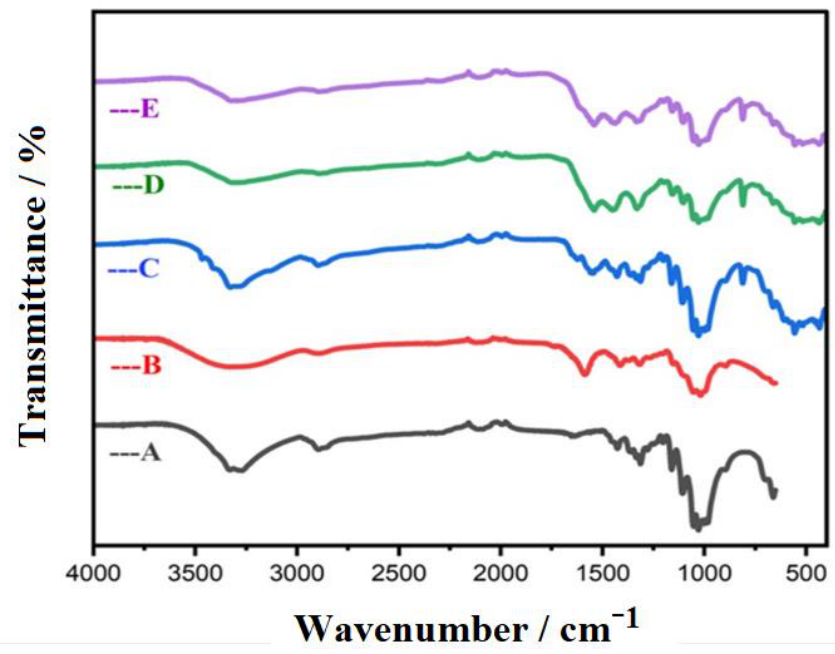
Figure 6. FTIR spectra for ( A ) cellulose, ( B ) CMC, ( C ) CMC/Melamine, ( D ) CMC/Melamine/Cu, and ( E ) CMC/Melamine/Zn composite.